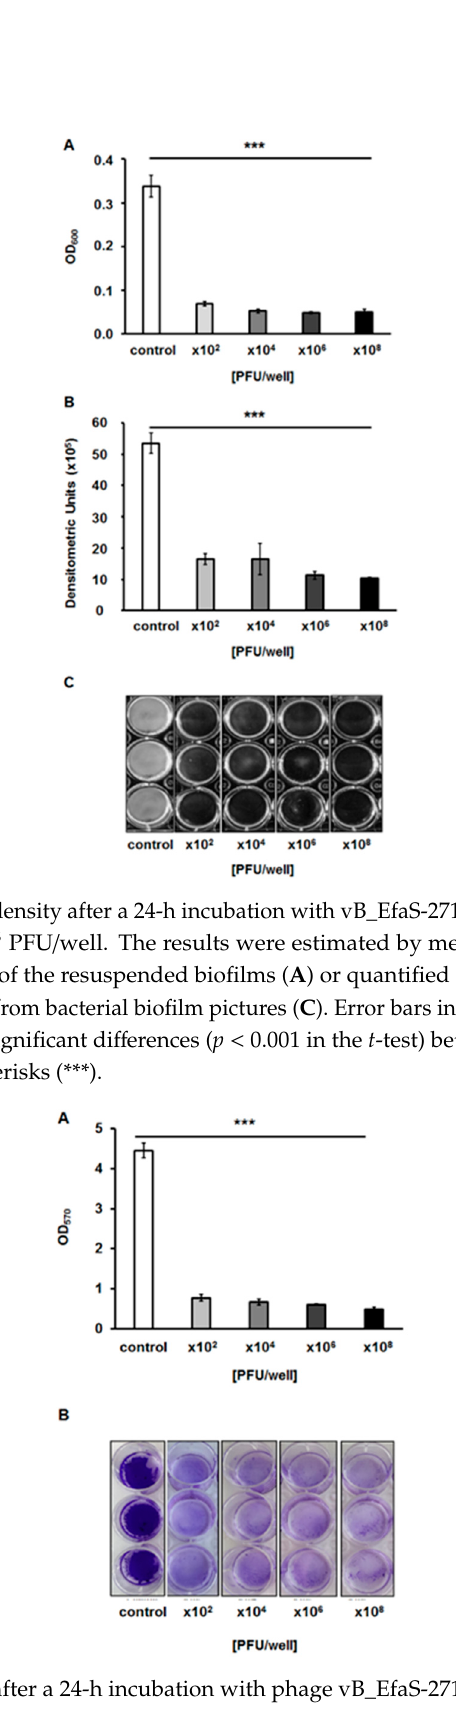
Figure 8. Biofilm biomass after a 24-h incubation with phage vB_EfaS-271 added to final titers of 10 2 , 10 4 , 10 6 or 10 8 PFU/well, as analyzed by the crystal violet staining method and shown as optical density values measured at a wavelength of 570 nm ( A ) or photographed ( B ). The results are presented as the mean values ± SD from three independent experiments. Statistically significant differences ( p < 0.001 in the t -test) between control and analyzed samples are marked by asterisks (***).